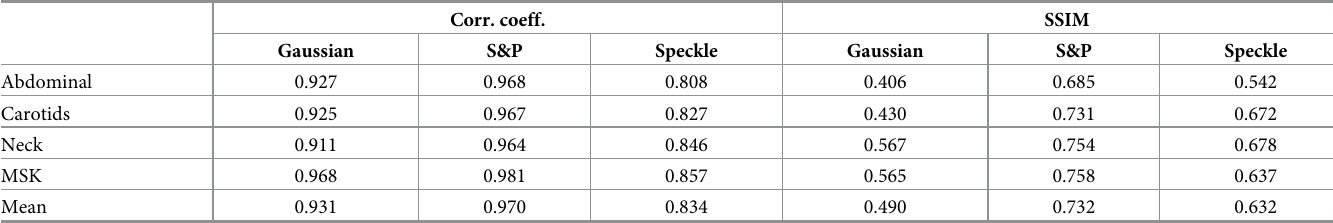
Table 2. Median comparison of SSIM and correlation coefficient for Db30 wavelet with decomposition level 3 and various noise levels and datasets. Corr. coeff. SSIM Gaussian S&P Speckle S&P